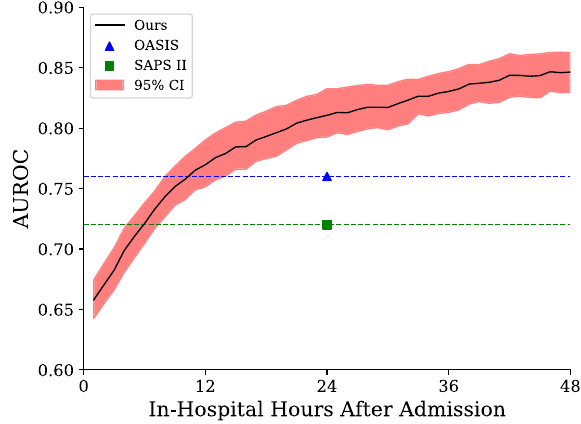
Figure 6. Comparison of our model’s dynamic predictive performance over the initial 48 h of the patient stay against OASIS and SAPS II calculated at 24 h (calculated in Harutyunyan et al. 21 ). Confidence intervals were bootstrapped from the ten-fold cross-validation. Our model exceeds the performance of traditional scoring systems early in the patient stay, before continuing to improve during their